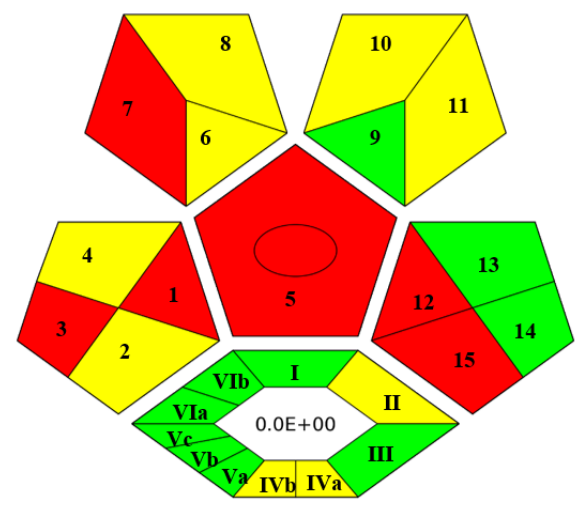
Figure 3. ComplexGAPI pictogram for proposed method.